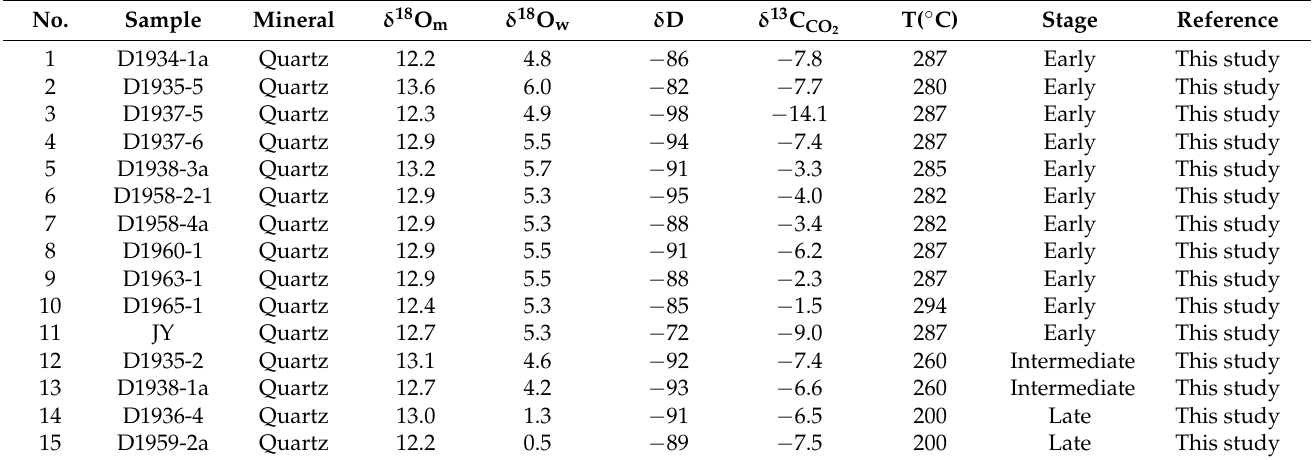
Table 2. The δ 18 O, δ D, and δ 13 C ratios (‰) of the Juyuan tungsten